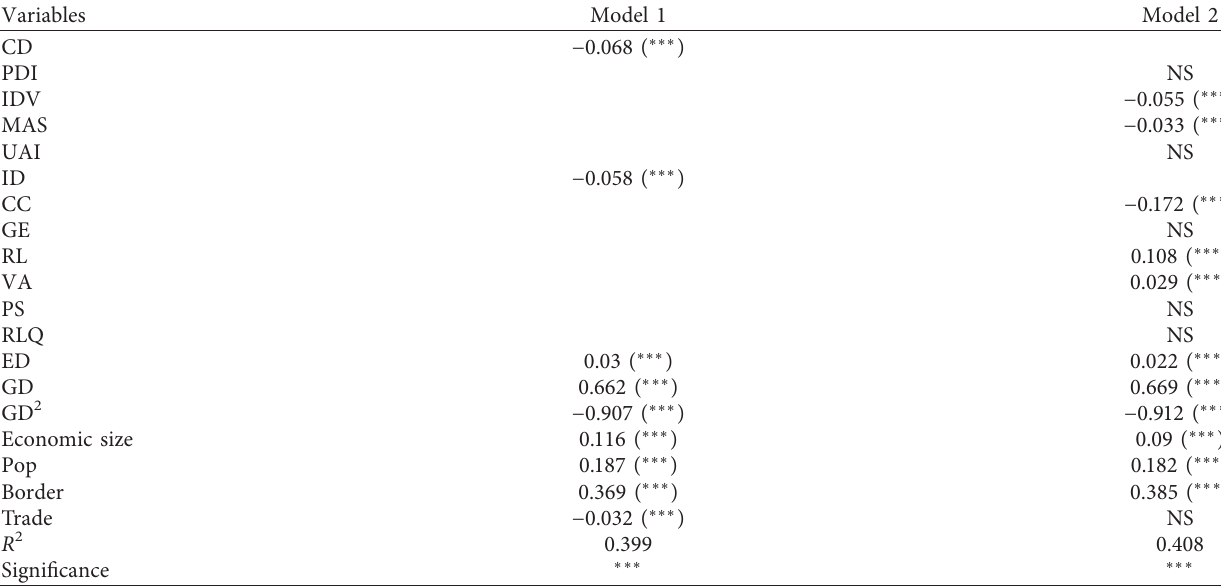
Table 3: Estimation results for the OLS